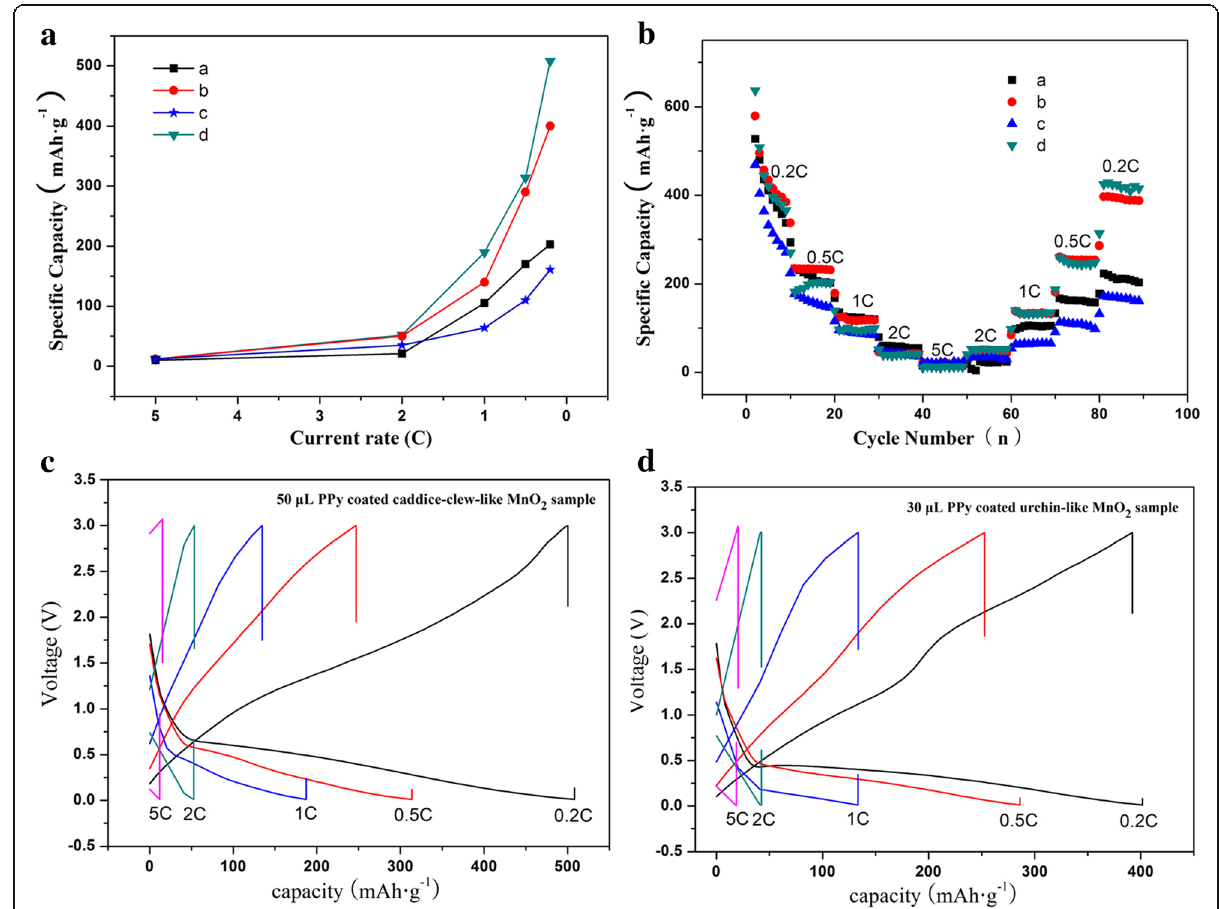
Fig. 7 a Rate capability, b rate performance, and c , d charge-discharge curves of the MnO 2 @PPy samples. ( a , b ) Urchin-like MnO 2 sample and 30 μ L PPy-coated sample. ( c , d ) Caddice-clew-like MnO 2 sample and 50 μ L PPy-coated